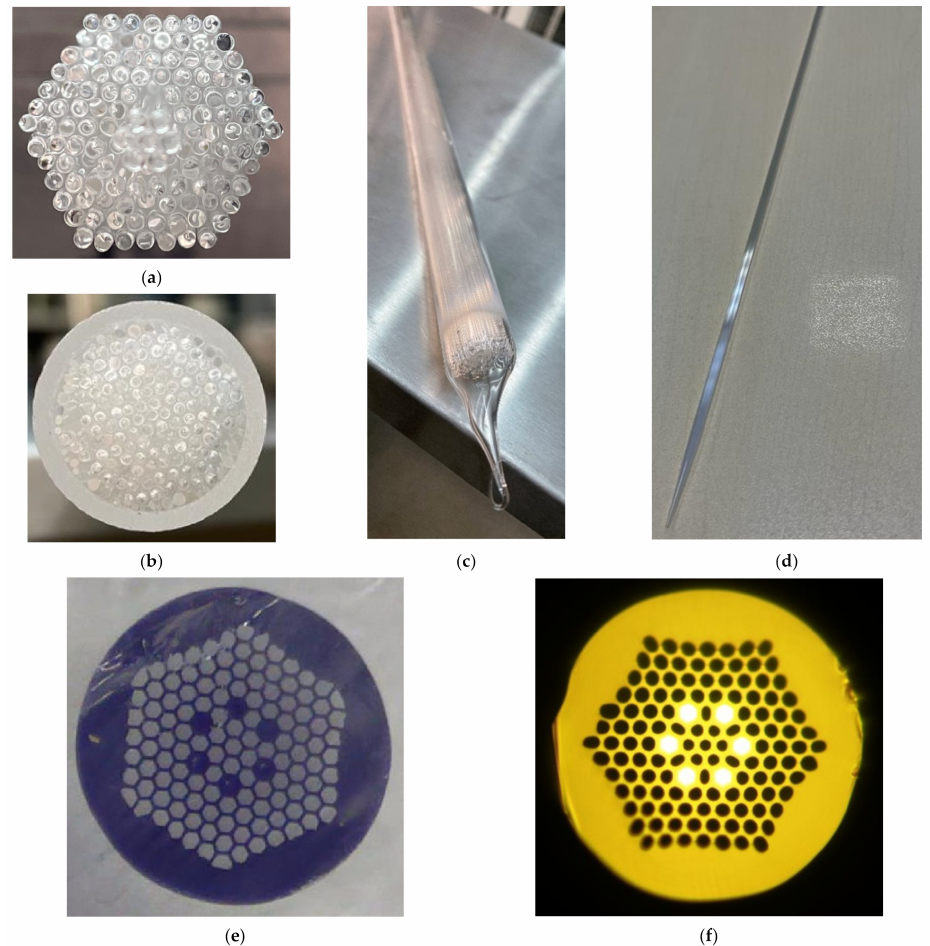
Figure 5. Six-core-MOF: ( a ) stack; ( b ) stack inside a silica tube; ( c ) MOF preform; ( d ) MOF cane; ( e ) MOF cane cross-section; ( f ) MOF cross-section.